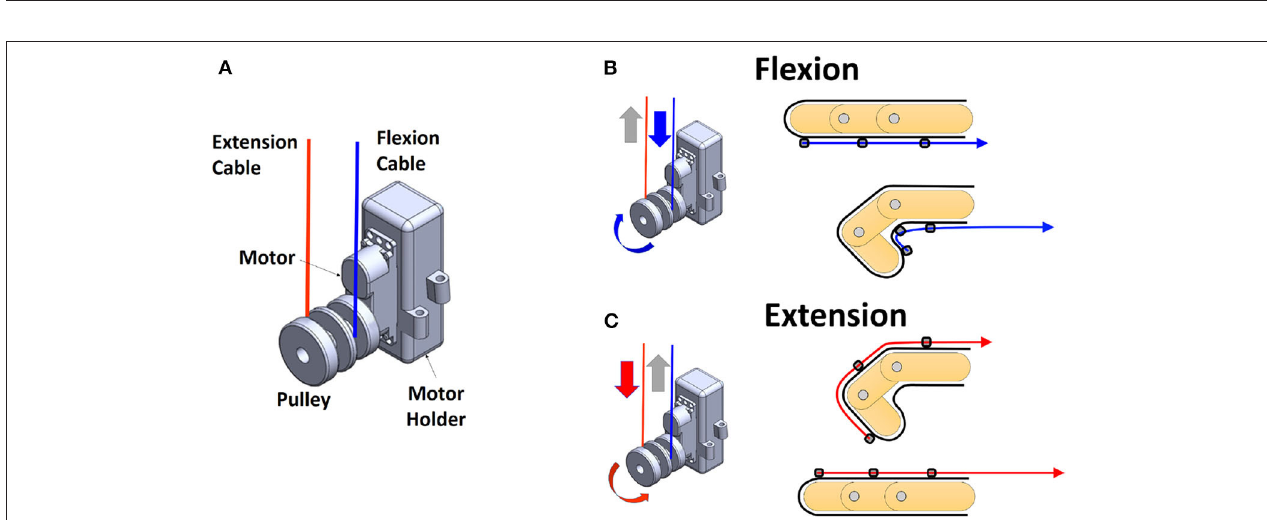
FIGURE 3 | An actuator unit and a finger flexion/extension mechanism with a single motor. (A) The overview of the actuator unit. (B,C) Schematic drawing of flexion and extension by the rotation direction of the motor.